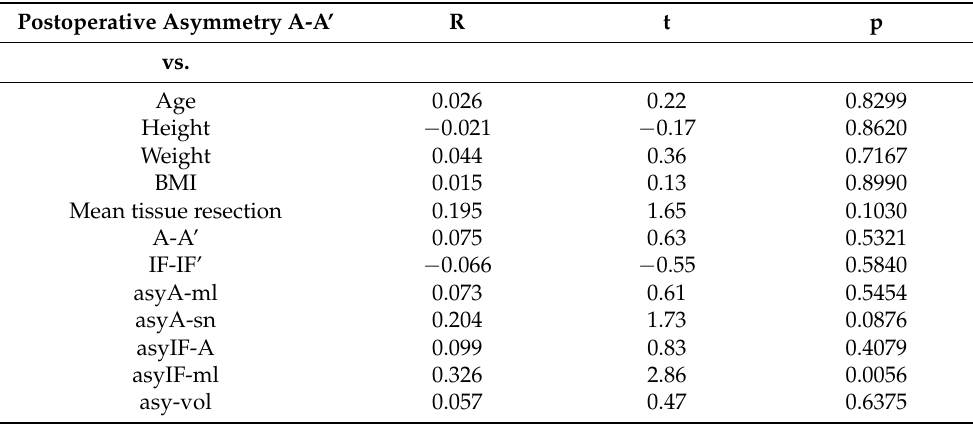
Table 3. Relationship between the postoperative asymmetry of nipple position (6 months after breast reduction) and clinical and preoperative metric variables.